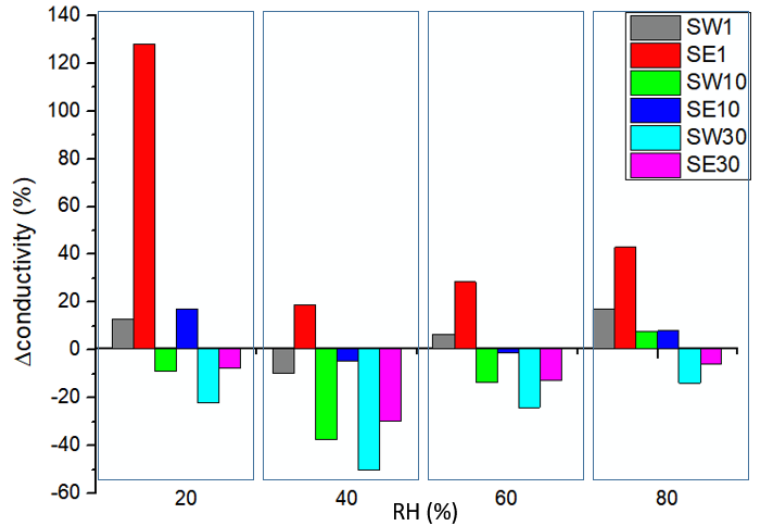
Figure 7. Conductivity variation for the RF-modified PFSA membranes relative to the reference membrane conductivity at different levels of relative humidity.